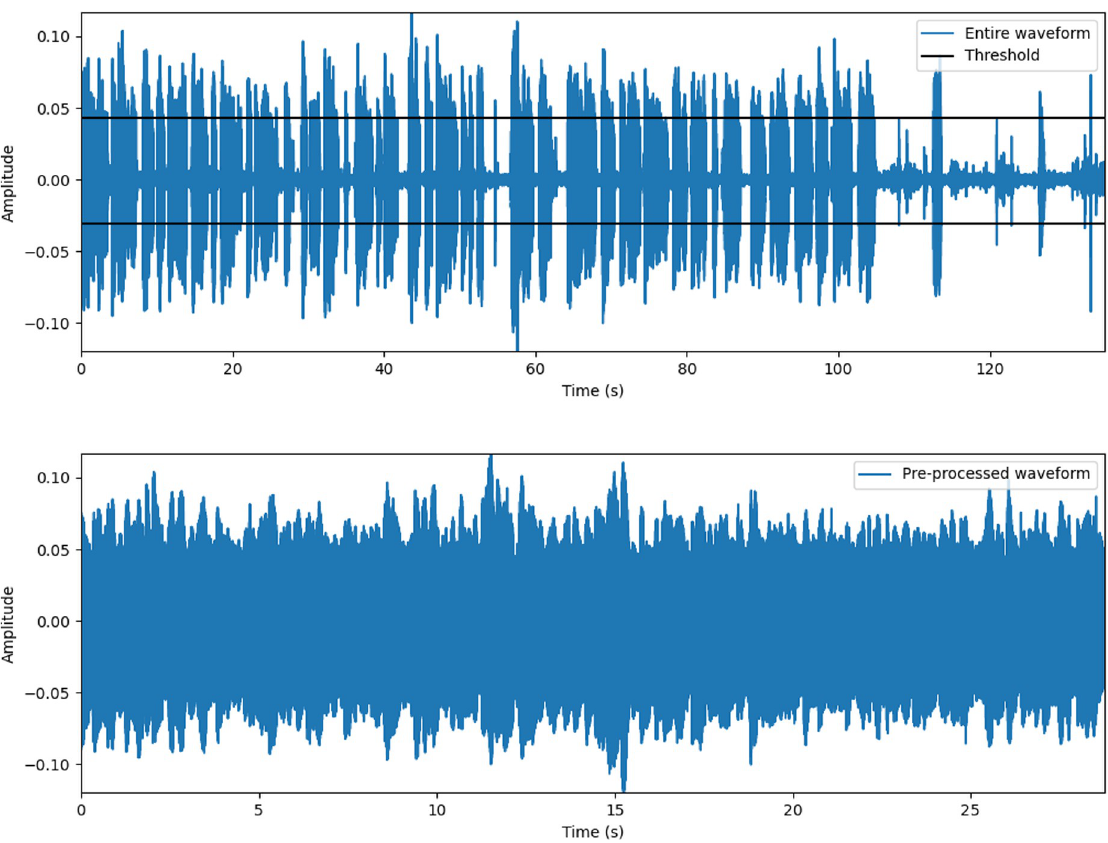
Fig 1. Illustration of the pre-processing process. Top: entire waveform (blue line) and threshold (black line). Bottom: pre-processed waveform where only the values above the threshold were extracted.